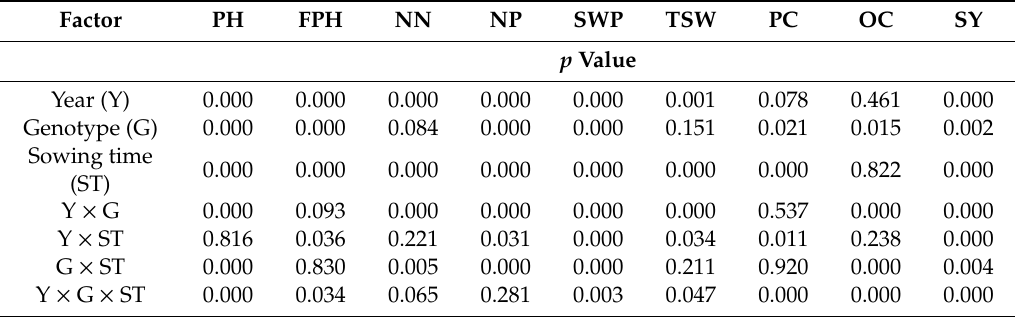
Table 1. ANOVA for the e ff ect of year, genotype, and sowing time on the investigated parameters. Factor PH FPH